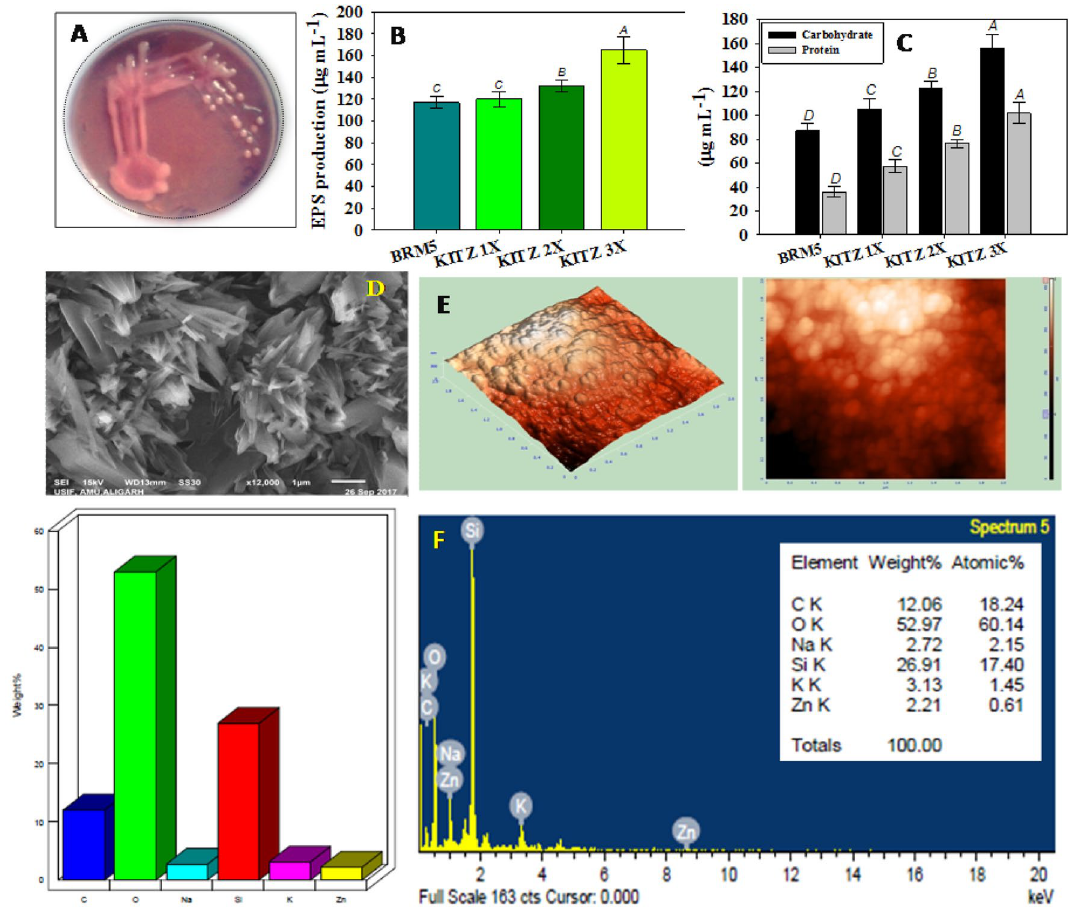
Figure 4. Exopolysaccharide (EPS) producing cultures of M. ciceri on YEMA plate ( A ), Bar diagrams represents the EPS synthesized by strain BRM5 in the presence of varying concentrations of KITZ ( B ), quantification of EPS; carbohydrate and protein content ( C ), morphological analysis of dried powder of EPS under SEM ( D ), topographical analysis of dried powder of EPS under Atomic force microscope (AFM) ( E ), EDX analysis of dried powder of EPS showing the presence of various elements ( F ).